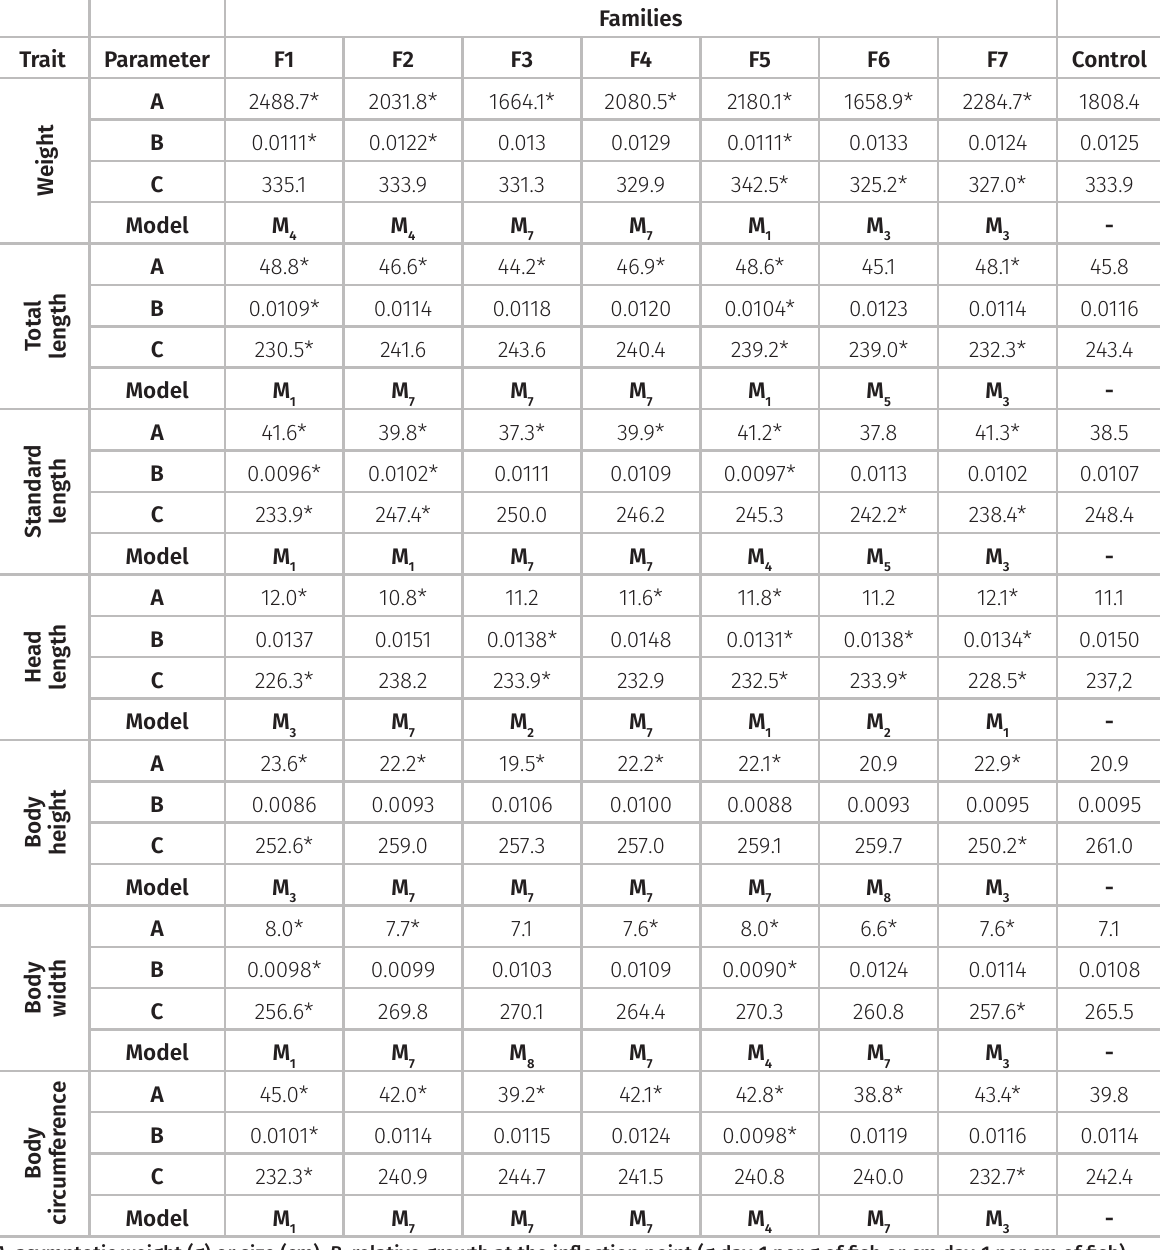
Table II. Estimates of parameters of the best fitting models for weight, total length, standard length, head length, body height, body width, and body circumference of selectively bred families of tambaqui ( Colossoma macropomum ) and control group (non-selectively bred) after 254 days of culture